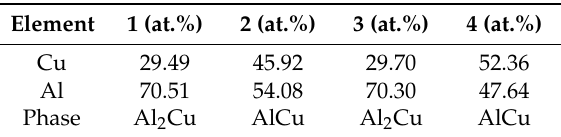
Figure 8. Peeled surface morphology (BSE image) and EDS results of the as-cast Cu/Al clad sheet: ( a ) Cu side and ( b ) Al side. Table 4. The EDS results for the peeled surfaces in Figure 8.